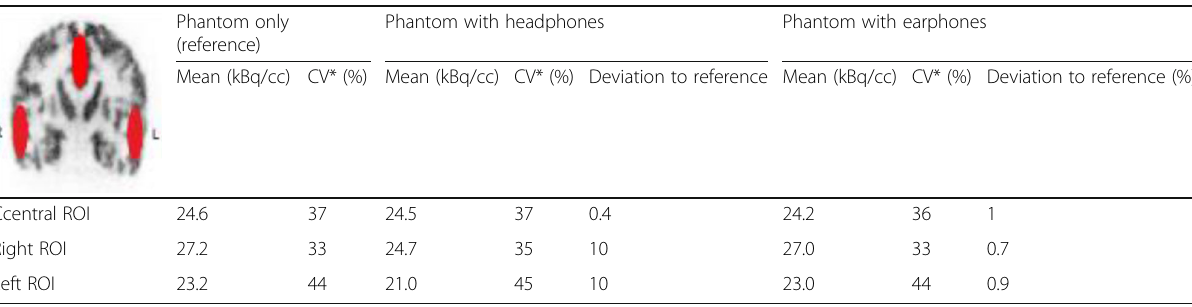
Table 1 ROI analysis of the emission image. Drawn ROIs nearby the headphones location and results Phantom only (reference)